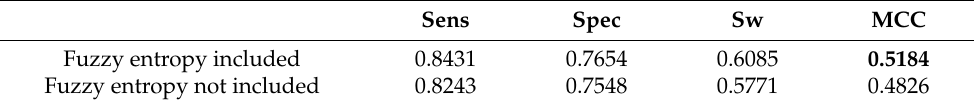
Table 10. Influence of fuzzy entropy on BP-FE prediction results.